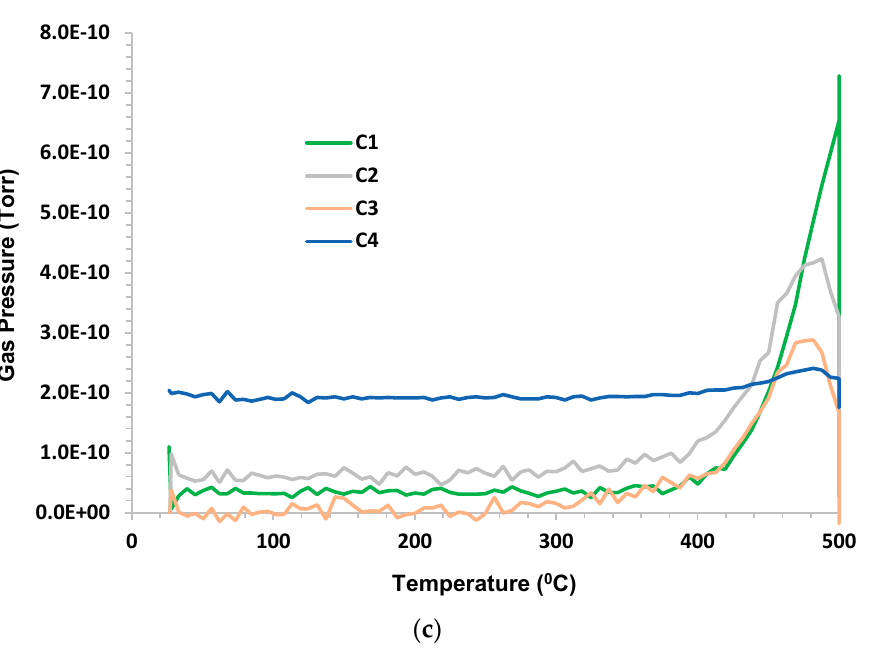
Figure 7. Woodford shale in humid CO 2 . ( a ) Gas pressure and temperature as a function of time. ( b ) H 2 evolved (vol%) as a function of time. ( c ) Gas pressure as a function of temperature.